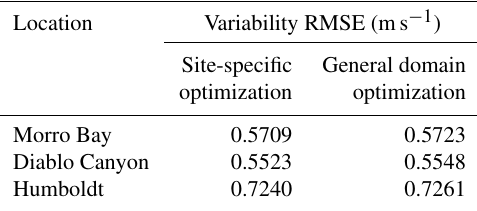
Table 3. Variability in the RMSE of two weight optimization schemes: site-specific optimization and general domain optimiza-